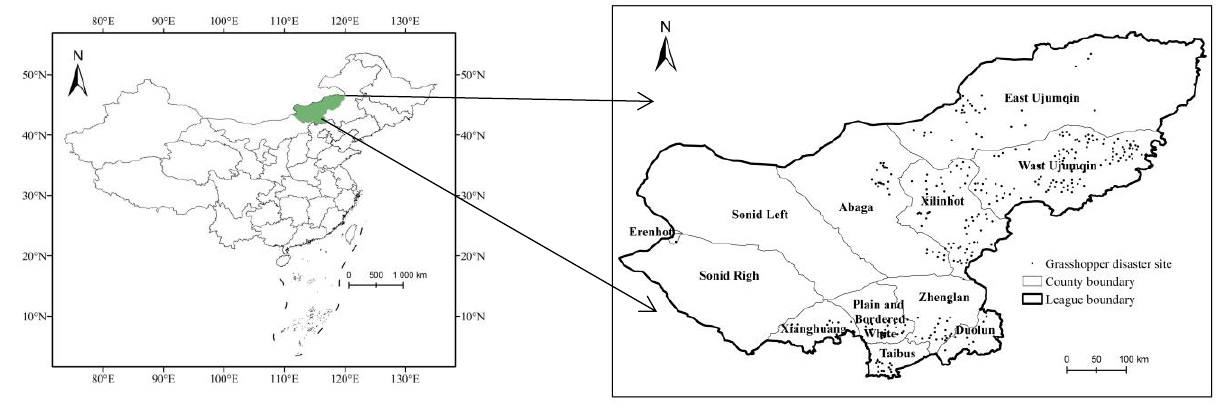
Figure 2. Experimental area location and field survey sampling positions of O. d. asiaticus .